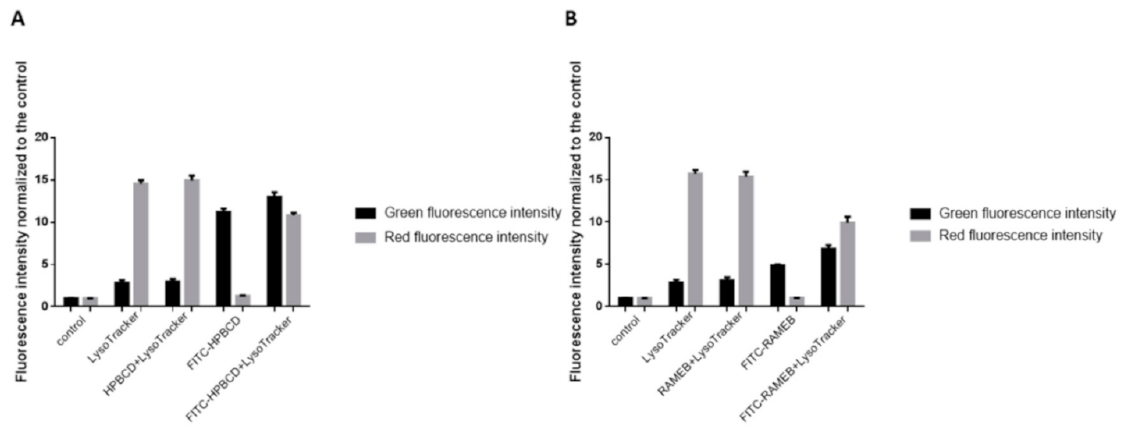
Figure 9. Flow cytometry analysis of lysosomes in Caco-2 cells. Mean ± SD are depicted ( n = 4). ( A ) HPBCD and FITC-HPBCD, ( B ) RAMEB and FITC-RAMEB